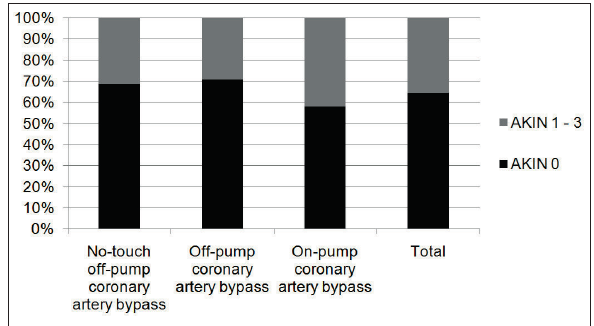
Fig. 2. Occurrence of